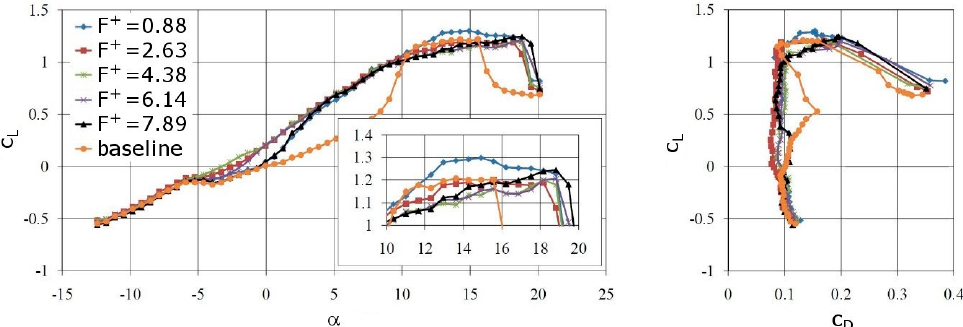
Figure 33. Lift curve and drag polar for Re = 64,200. Plasma actuator at 2% chord. (Reprinted from [29]).